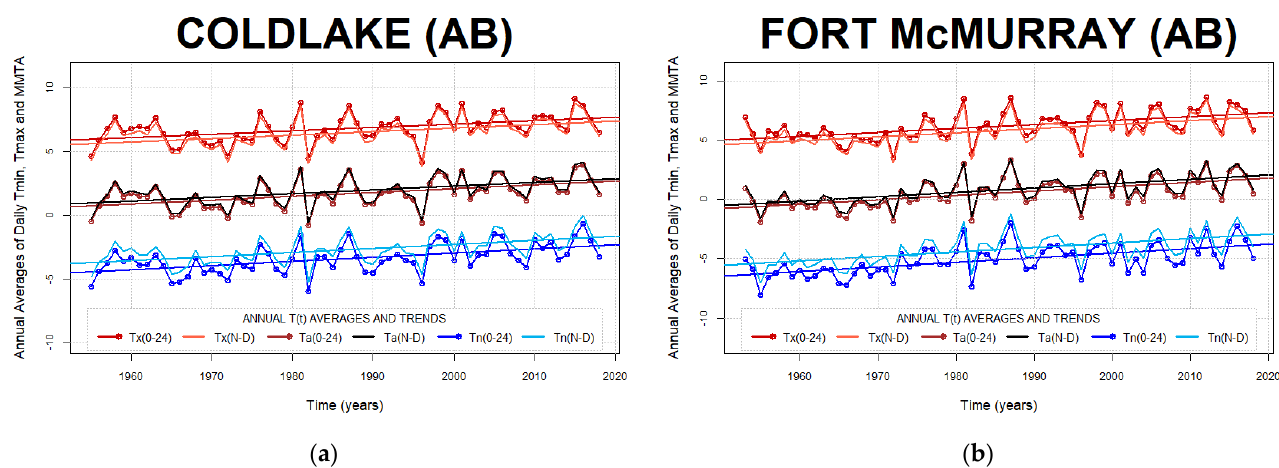
Figure A8. Northwestern Forest climate region. Effect of the observing window on long-term air temperature averaging at Cold Lake ( a ) and Fort McMurray ( b ) stations. Annually averaged diurnal air temperature minima, maxima, and Min-Max averages obtained with COW 0–24 and COW N–D air temperature approximating methods.